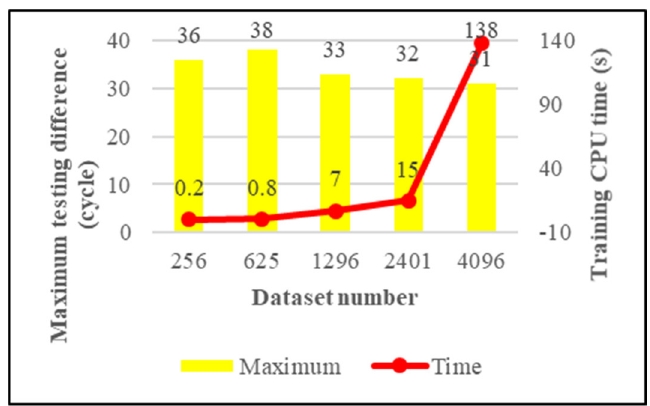
Figure 8. The maximum testing difference of the KRR model.